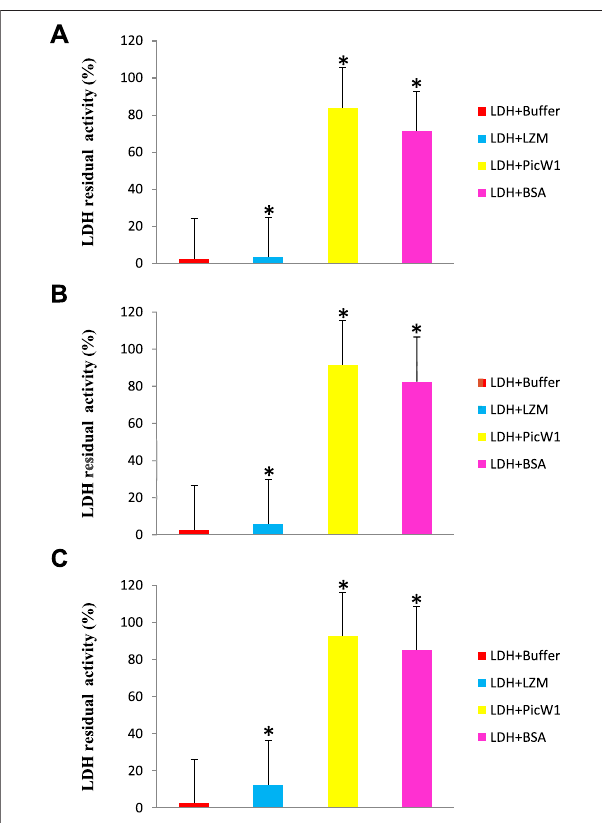
FIGURE 4 | PicW1 protected LDH activity from freeze-thaw stress. Different molar ratios of LDH solutions in the presence of BSA, LZM, and puri fi ed recombinant proteins PicW1 were subjected to freeze-thaw stress for the speci fi ed times (A) , 5:1; (B) , 10:1; (C) , 20:1 represent the molar ratio of added protein to LDH; the buffer group only has LDH. LDH activity was measured at each particular time point. The results are expressed as the LDH activity (%) relative to the activity before treatment. Three independent assays were performed, and SE was included. Values are the mean ± SD (n = 3). Signi fi cant differences in the LDH enzyme activity retention are indicated as * p < 0.05, which were evaluated with a t -test ( t -test was performed on the protective effect of every two proteins of LZM, PicW1, and BSA on LDH).